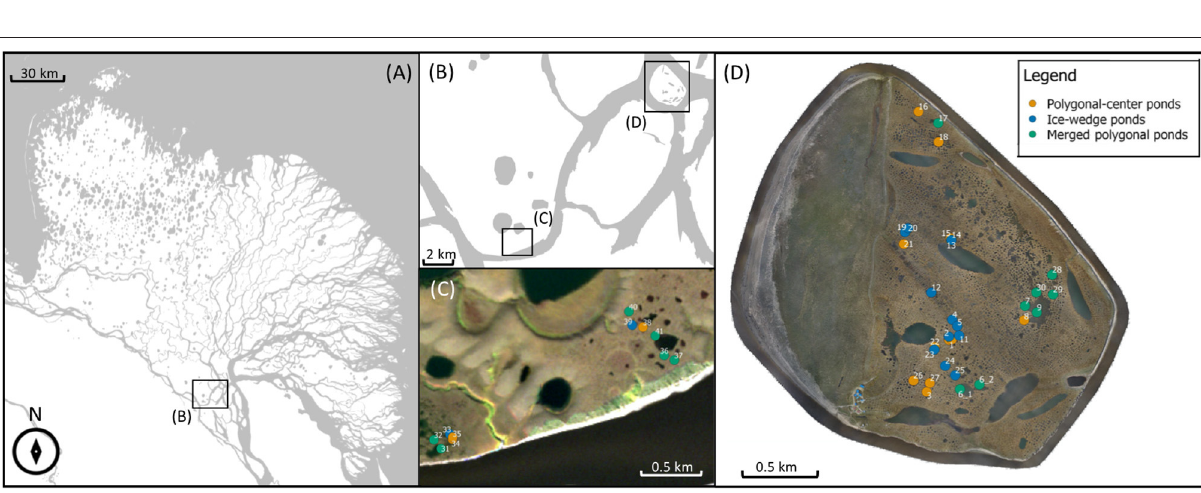
FIGURE 2 | Overview of study region. The Lena River Delta (A) is located in Eastern Siberia at the coast of the Laptev Sea. Samoylov and Kurungakh Island are situated in the southern end of the Delta (B–D) . Maps in (A,B) adapted from OpenStreetMap contributors, under Open Database License. Each dot represents one sampled pond (C,D)